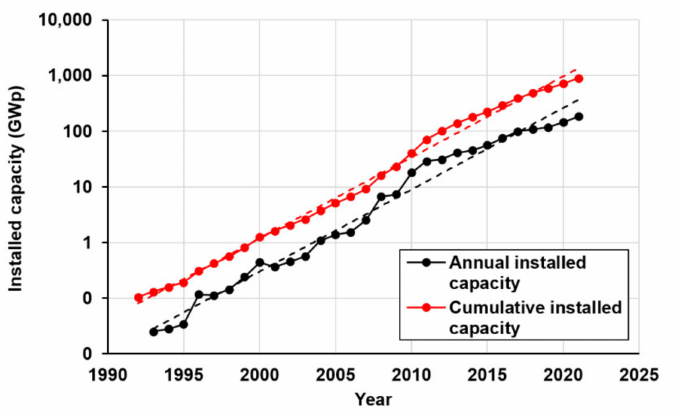
Figure 1. The developments of the cumulative capacity and annual